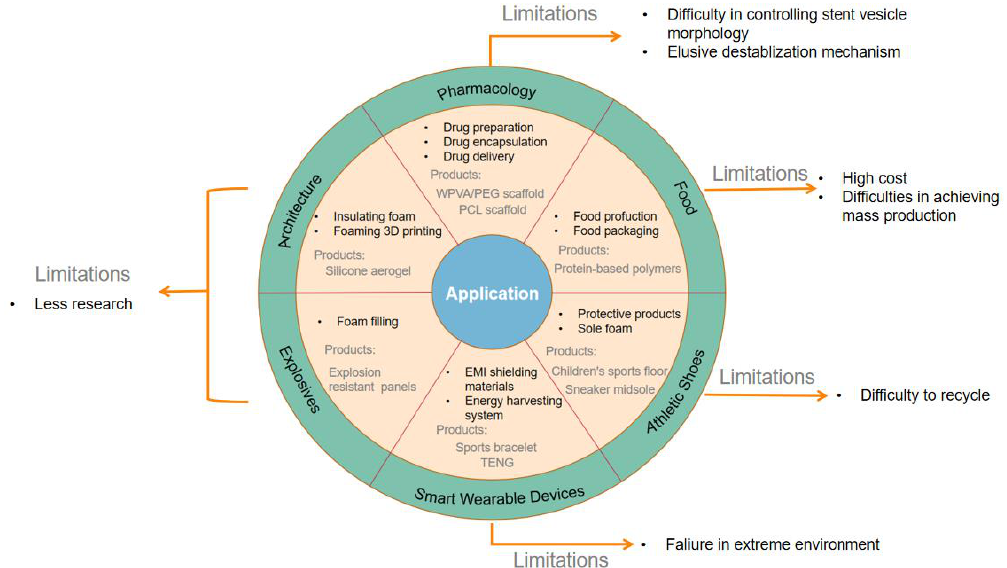
Figure 4. Application of supercritical foaming technology in various fields.